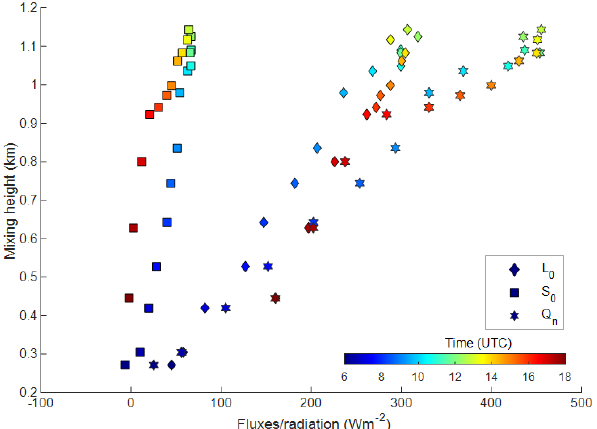
Figure 7. Correlation of the mixing layer height MLH with the sur- face sensible and latent heat fluxes ( S 0 and L 0 ) and the net radia- tion ( Q n ). The color indicates the time of the day.